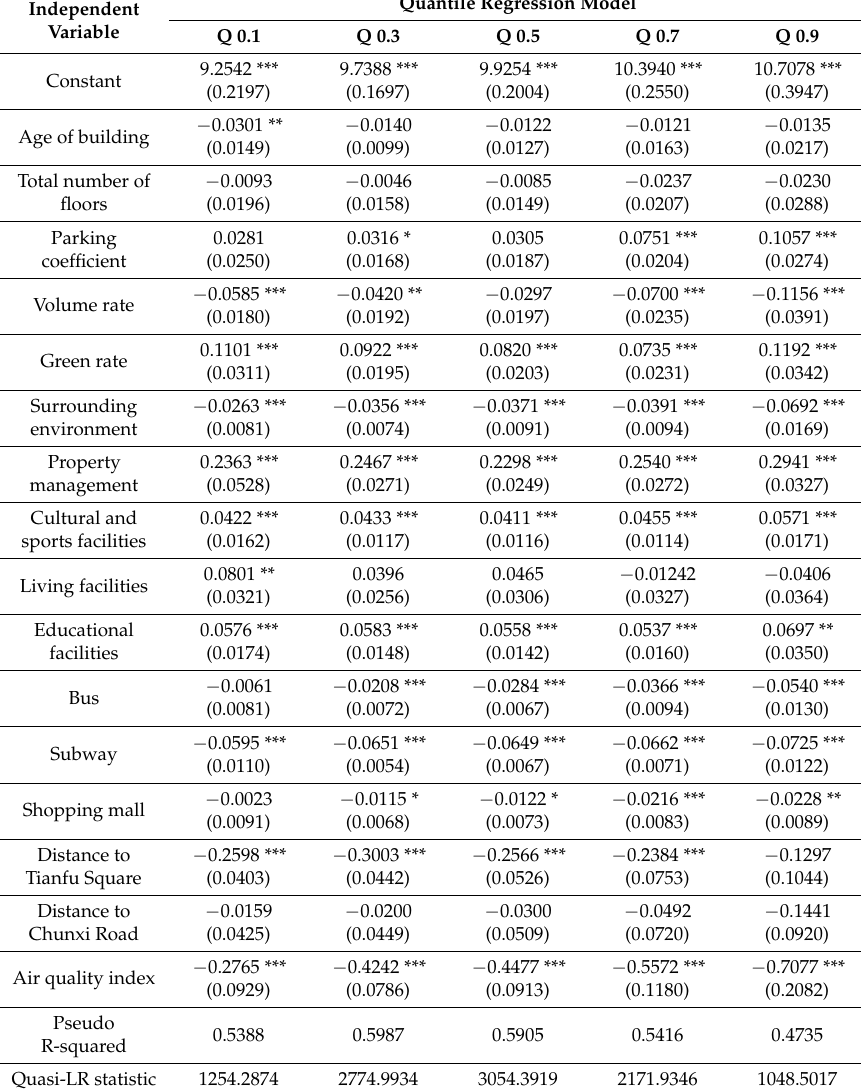
Table 8. The quantile regression results for housing selling prices.